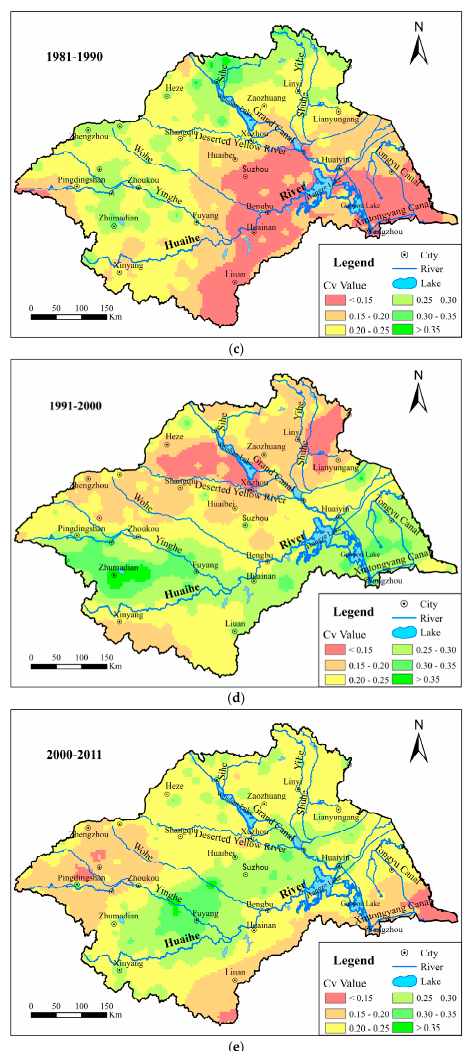
Figure 5. The spatial distribution of randomicity in the different decadal precipitation (( a ) from 1961 to 1970; ( b ) from 1971 to 1980; ( c ) from 1981 to 1990; ( d ) from 1991 to 2000; ( e ) from 2001 to 2011).